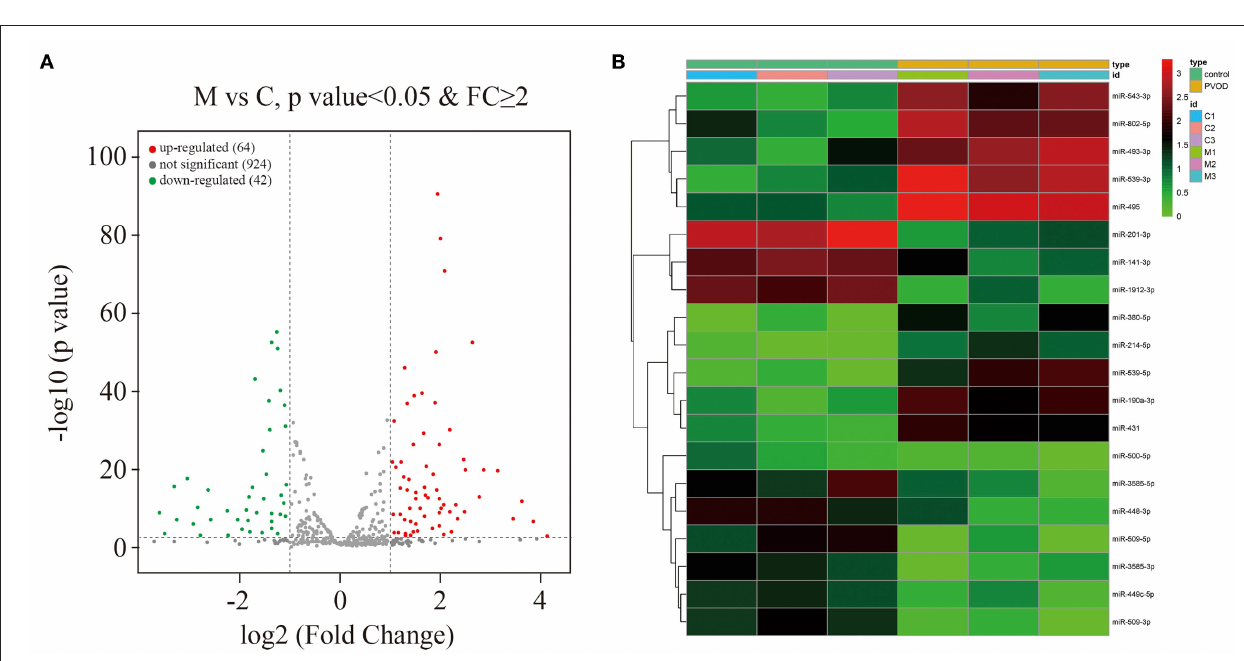
FIGURE 7 | Overview of the miRNA profiles. (A) The volcano plot of differential expressed miRNAs in PVOD compared with control group. The upregulated expressed miRNAs were presented in red ( ≥ 2-fold change and P < 0.05), the downregulated expressed miRNAs were presented in green ( ≥ 2-fold change and P < 0.05), while no differentially expressed miRNAs were presented in gray ( P ≥ 0.05). (B) Hierarchical clustering showed the top ten upregulated miRNAs and top ten downregulated miRNAs in PVOD group (yellow bar) compared with control group (green bar). The expression was displayed on a scale from light to deep. C, C1–C3 were the control group; M, M1–M3 were the PVOD group. FC, fold change; PVOD, pulmonary veno-occlusive